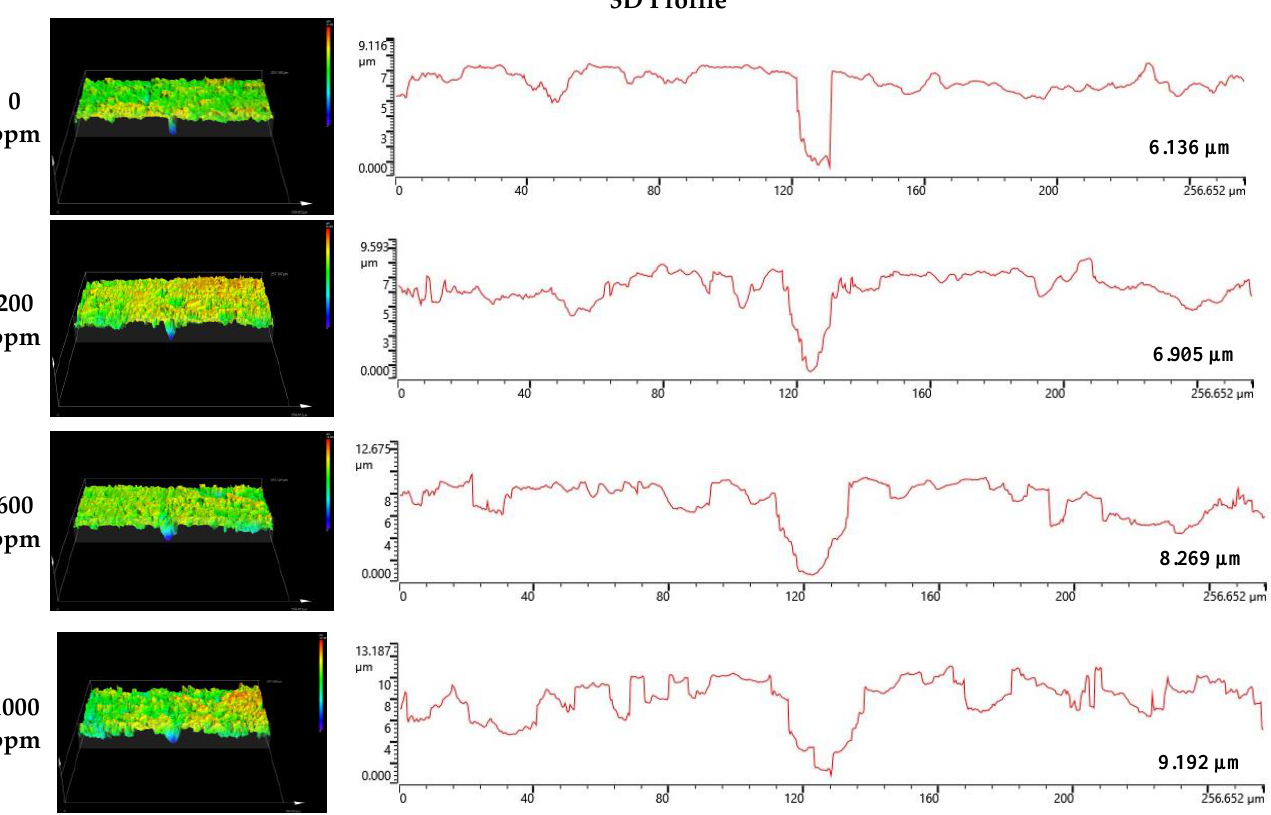
Figure 8. 3D analysis of damaged surface for 304 stainless steel after a potentiodynamic polarization experiment.